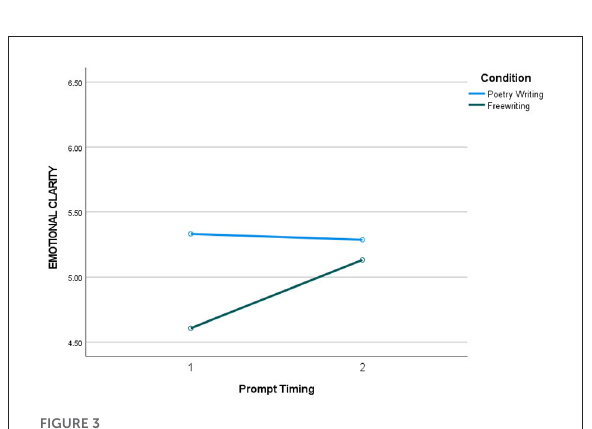
FIGURE3 Line chart comparing 2 writing conditions for levels of emotional clarity at two time